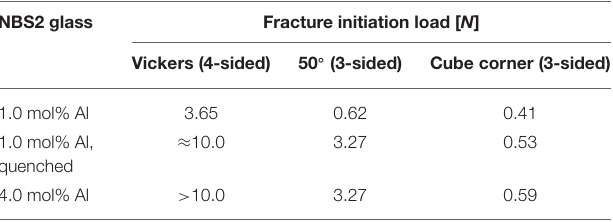
TABLE 4 | Fracture initiation load in N, determined with sigmoidal fits from fracture probability plots ( Figure 7 ). NBS2 glass